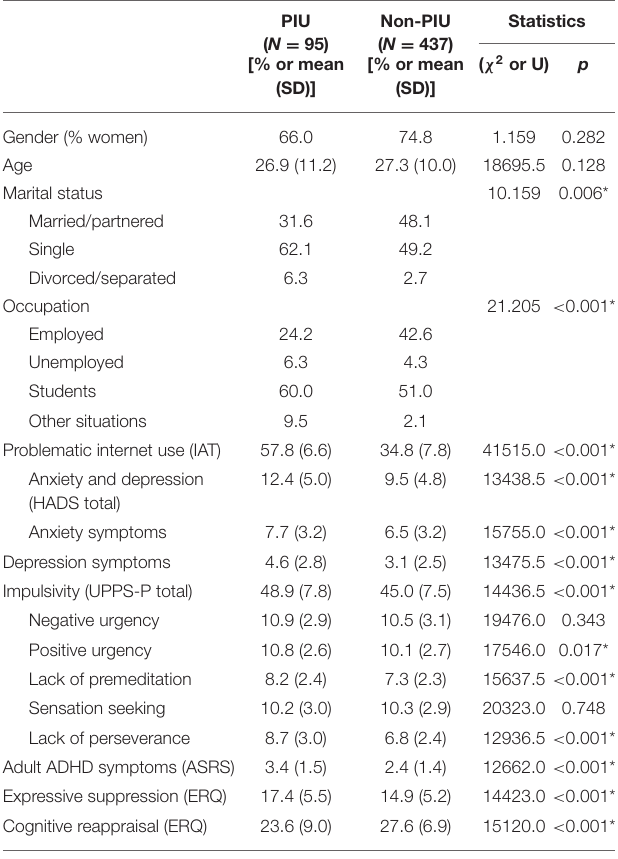
TABLE 1 | Socio-demographic data and independent variables: comparison of PIU and non-PIU